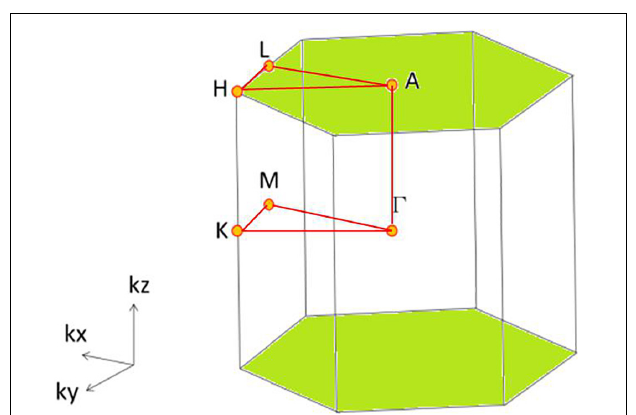
FIGURE 2 | Selected high-symmetry points in the first Brillouin zone. The k z = π plane is shown in